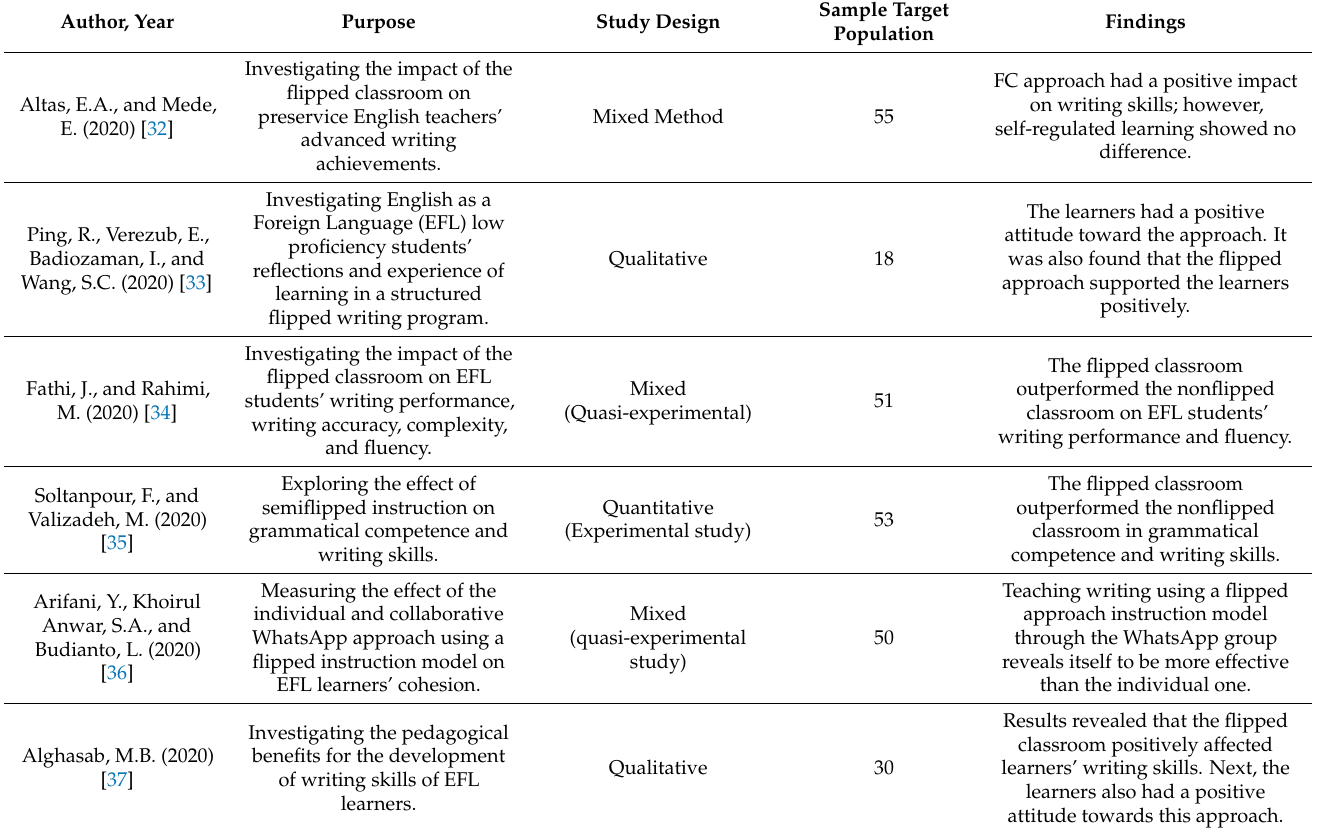
Table 2. Research papers conducted during